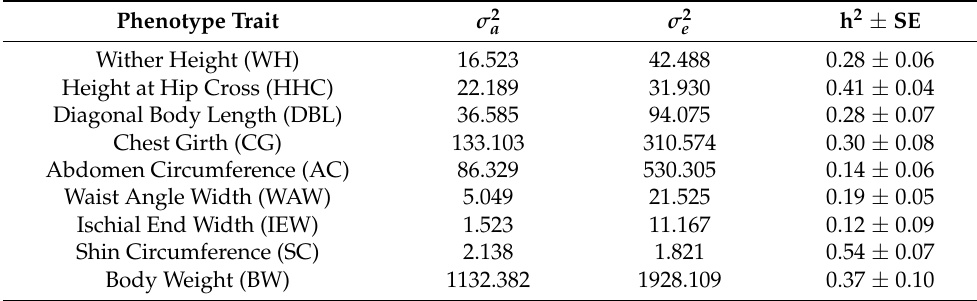
Table 1. Genetic parameters of body size and weight traits from the